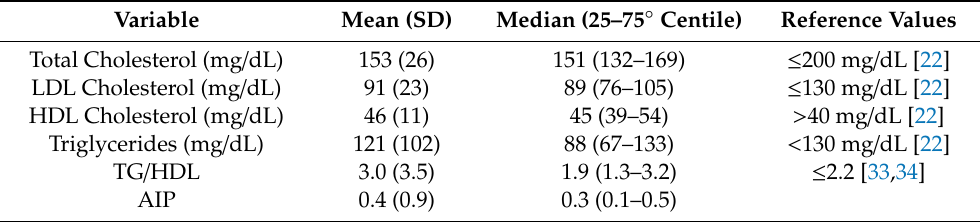
Table 4. Lipidic profile in obese adolescents. LDL, low-density lipoprotein, HDL, high-density lipoprotein, TG, triglycerides, AIP, atherogenic index of plasma.